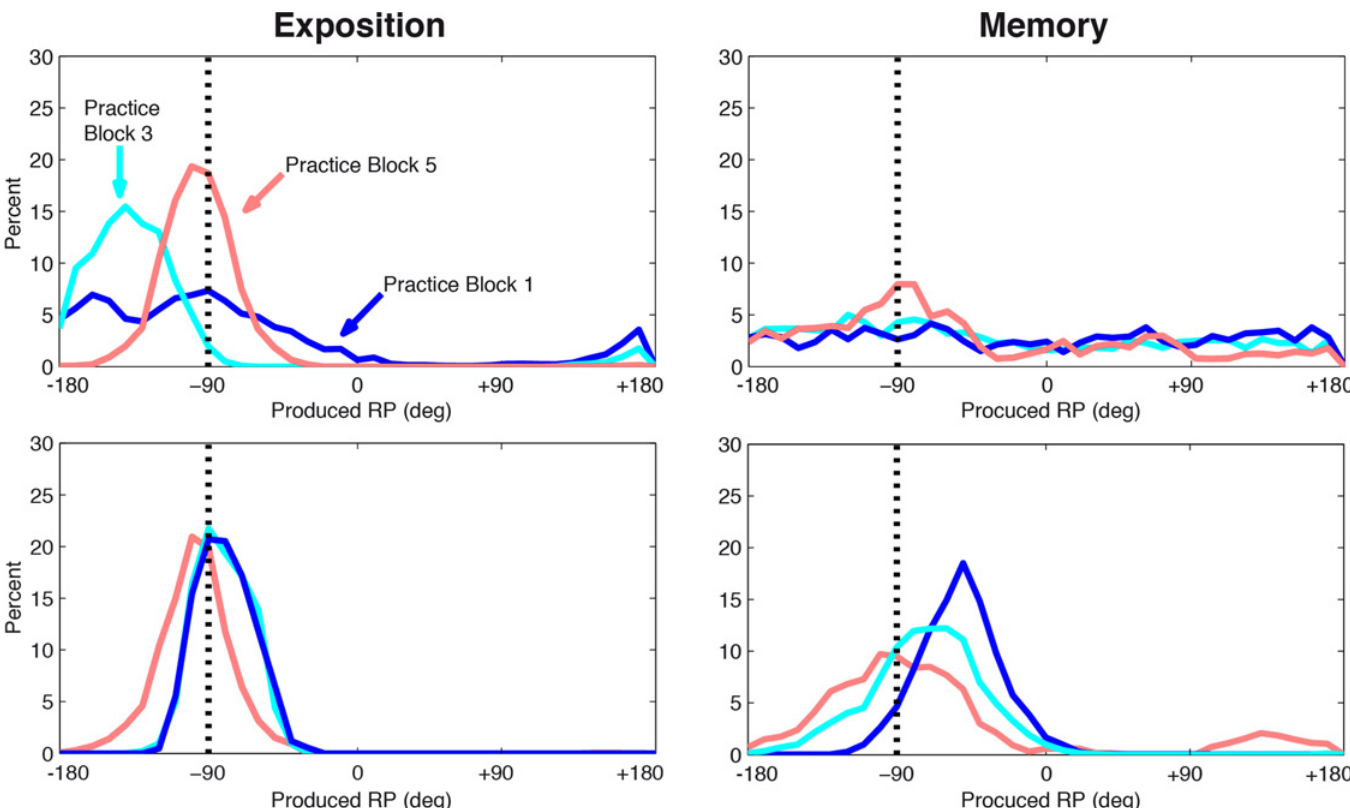
Fig 7. Learning a new Relative Phase. Individual distributions of produced RP during the first (blue line), third (cyan line) and last (red line) practice block for two individuals (top, and bottom panels, respectively). Left panels pertain to Exposition, right panels to Memory; the vertical dotted line represents the 90° RP specified by the VT. See text for